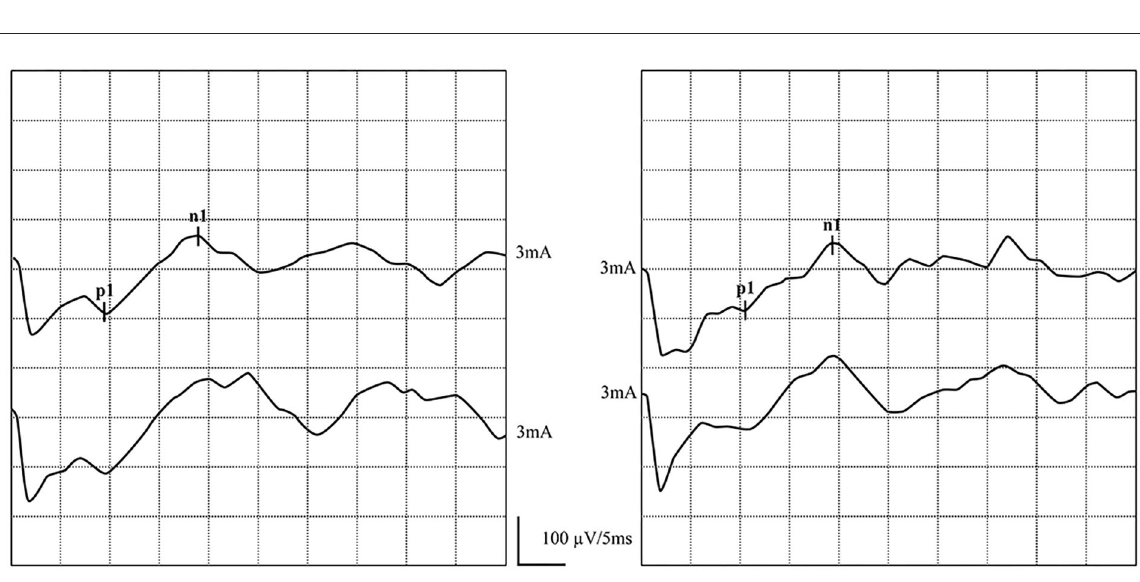
FIGURE5 Normal GVS-cVEMP waveforms: Elicited bilaterally. (left) GVS-cVEMP waveforms were elicited on the left side. (right) GVS-cVEMP waveforms were elicited on the right